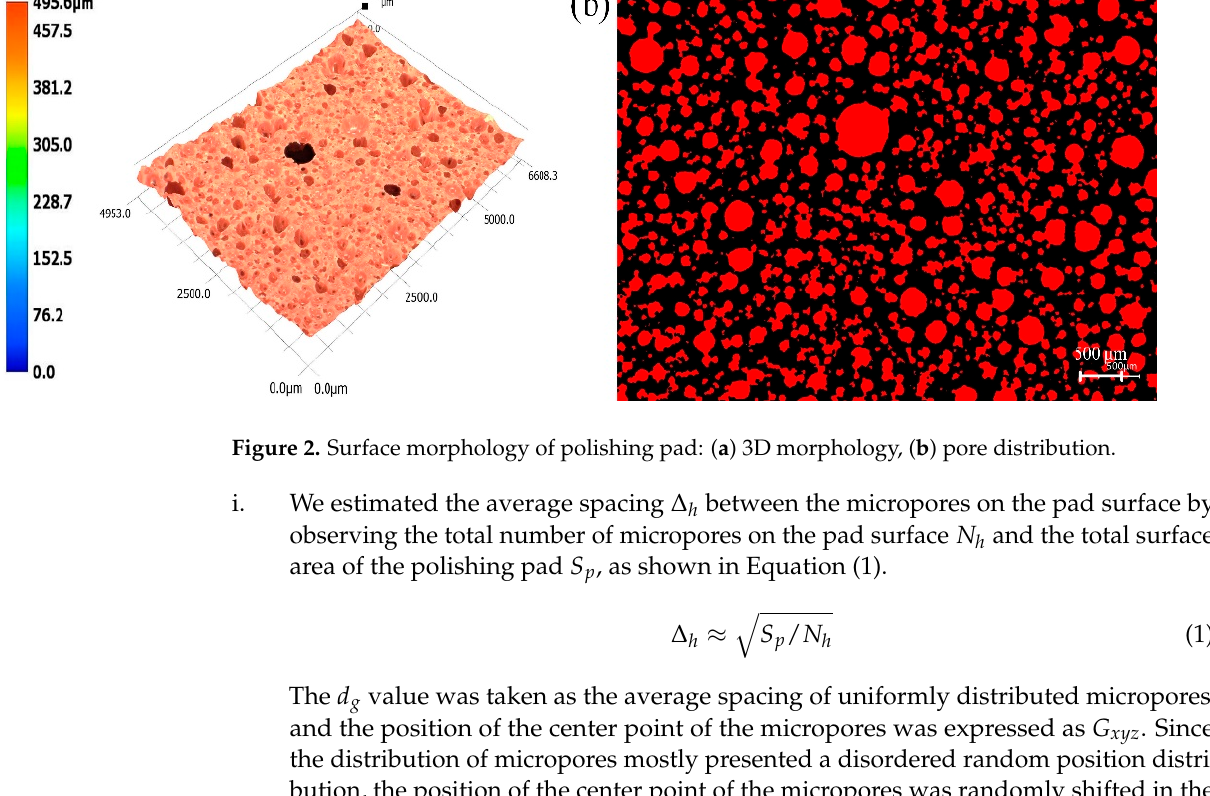
3 of 12 Figure 1. Flowchart of the theoretical modeling process for CCOS. 2.1. Modeling of Pad Surface Topography The polishing tool used in this paper was a porous polyurethane polishing pad. The pad surface was distributed with circular micropores and 2 mm × 1.5 mm diversion grooves. During the polishing process, the surface topography of the pad has a very im- portant influence on the removal mechanism of the polishing material. Therefore, in order to better understand the material removal process, it is necessary to study the surface to- pography characteristics of polishing pads. In this research, a KEYENCE VH7000 digital microscope was used to observe the surface morphology of the polishing pad, and the image recognition method was used to analyze and measure the distribution of the porous features on the pad surface. Figure 2a shows the measurement results of the surface mor- phology of the polyurethane polishing pad. We observed randomly distributed pores of different sizes on the pad surface. Figure 2b shows the pore distribution on the pad surface treated by the image recognition method. After the statistical analysis of the size of the pore area, we concluded that the pore area on the pad surface in the observation area accounted for 35% of the total observation area. In addition, the pore size on the pad sur- face was statistically analyzed, demonstrating that the average pore size was 85 μ m, and the fitted distribution curve showed an exponential distribution. After the hypothesis test,